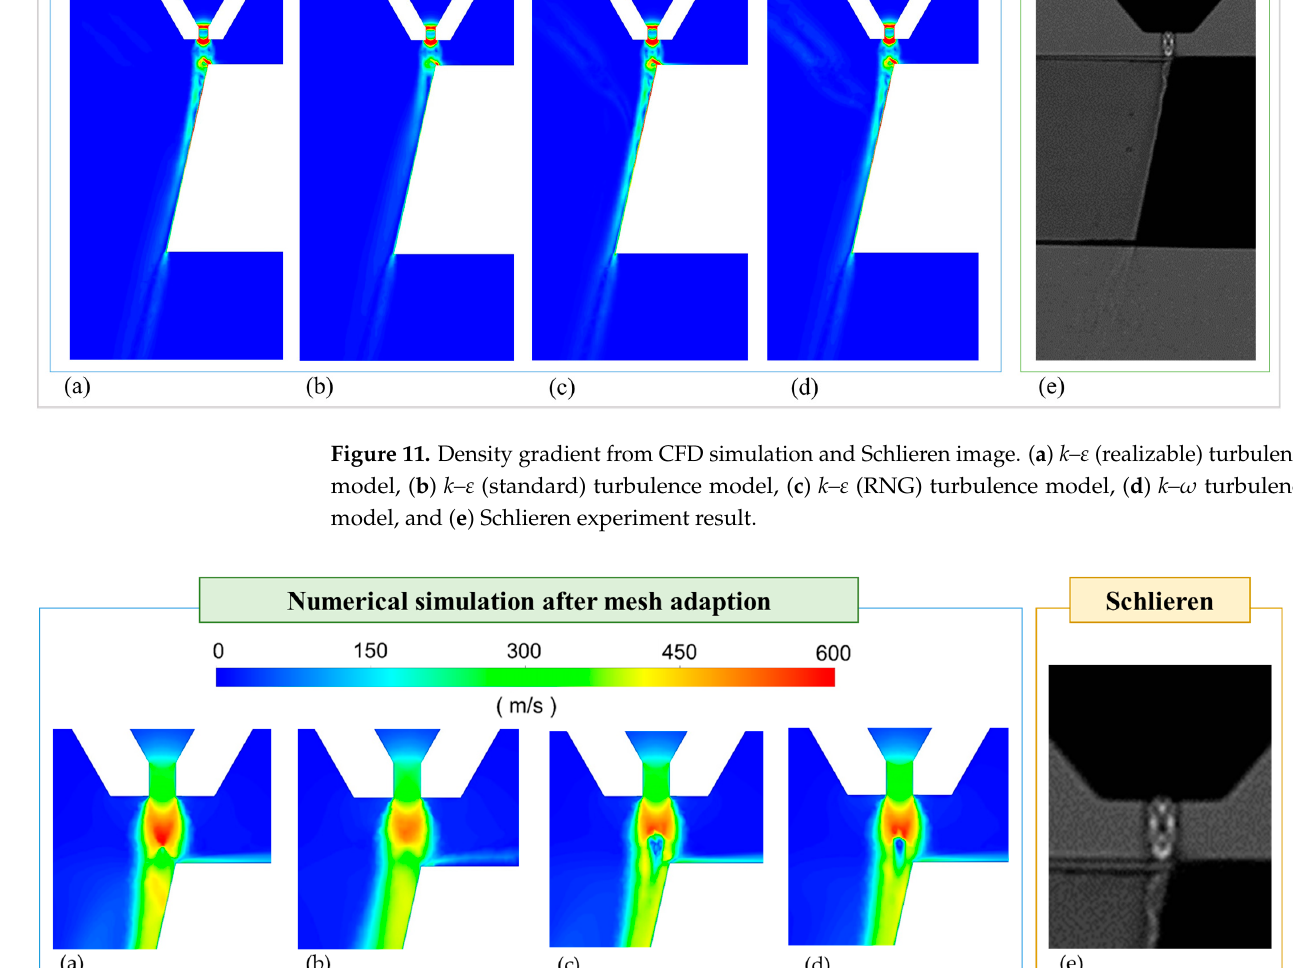
Figure 12. Velocity map at the stand-off distance predicted by numerical simulation after mesh adaption compared with Schlieren image. ( a ) k– ԑ (realizable) turbulence model, ( b ) k– ԑ (standard) turbulence model, ( c ) k– ԑ (RNG) turbulence model, ( d ) k– ω turbulence model, and ( e ) Schlieren experiment result.